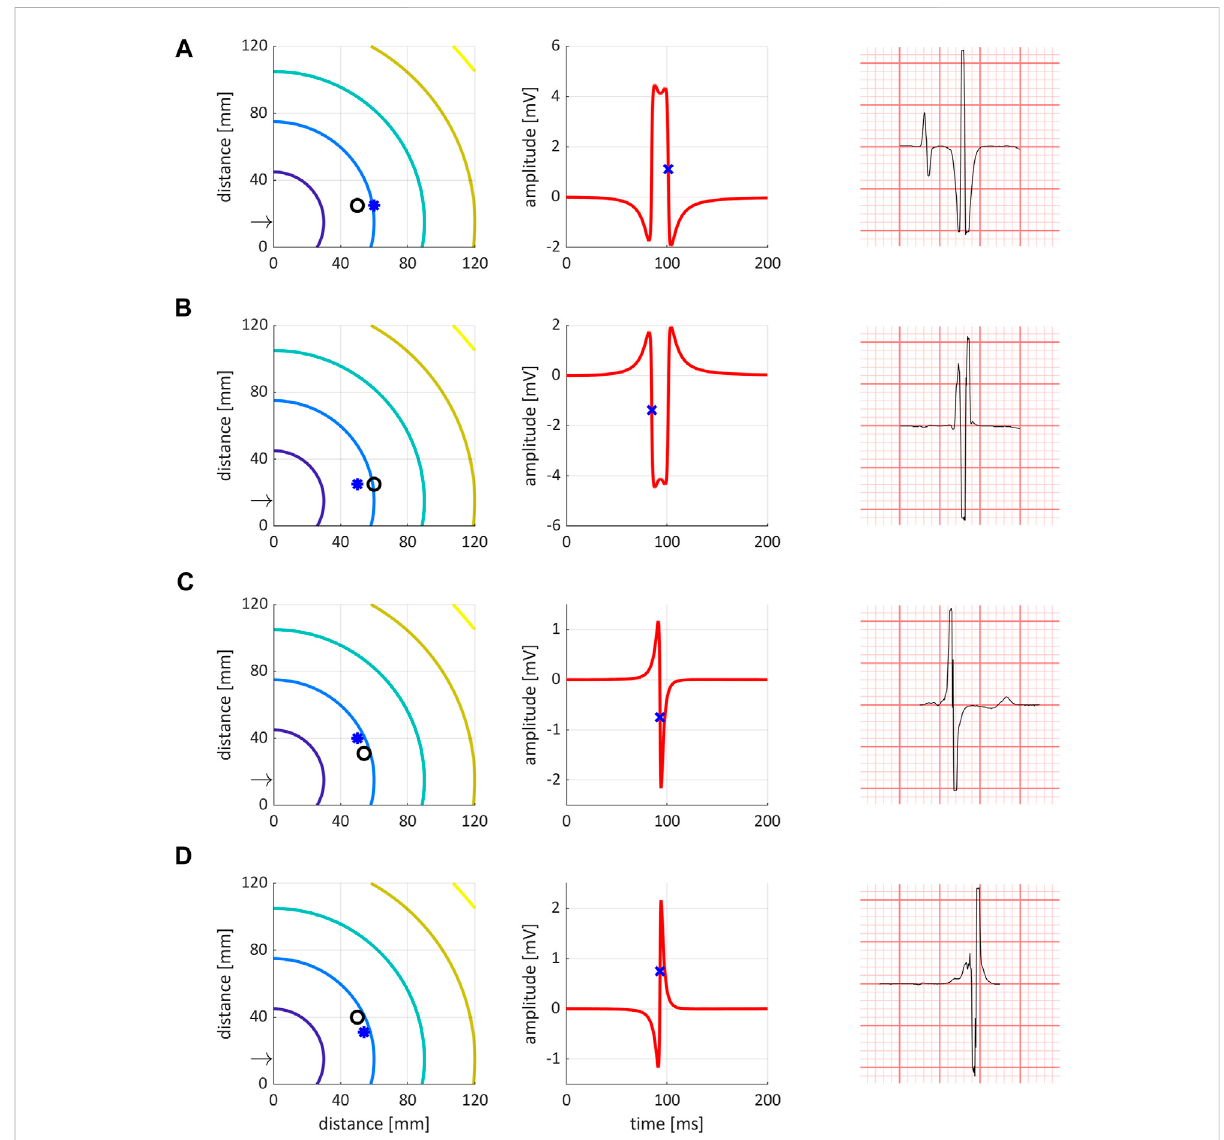
FIGURE 1 The four bipolar electrogram phenotypes identi fi ed and simulated. Left column are simulated isochrones, with the ring denoting the negative electrode,andthestardenotingthepositive cathetertipelectrode.The arrowpointstothestimulationsiteat( x =0 mm, y =15 mm).Middlecolumn shows simulated bipolar electrograms. Right column shows representative examples from the data. (A – D) (horizontal) show the four different con fi gurations. Please refer to the text for further